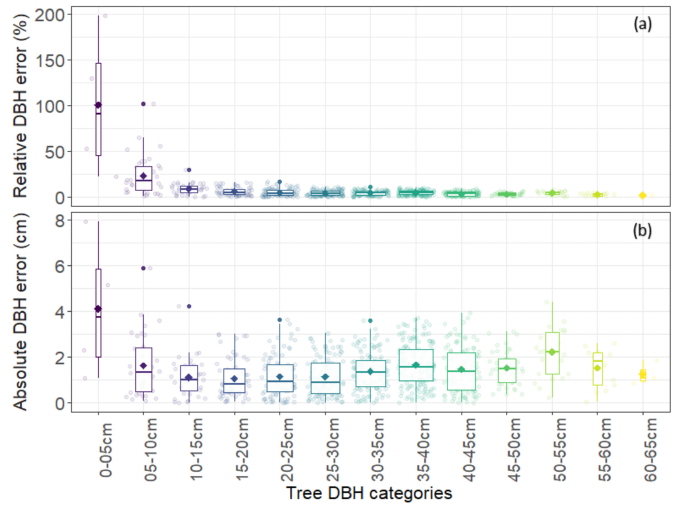
Figure 11. Variation of DBH categories in ( a ) MPE and ( b ) MAE between field-measured and MLS- measured values. Box plots show median error for each category and confidence intervals, with box width representing sample size. The mean error for each height class is represented by diamonds.